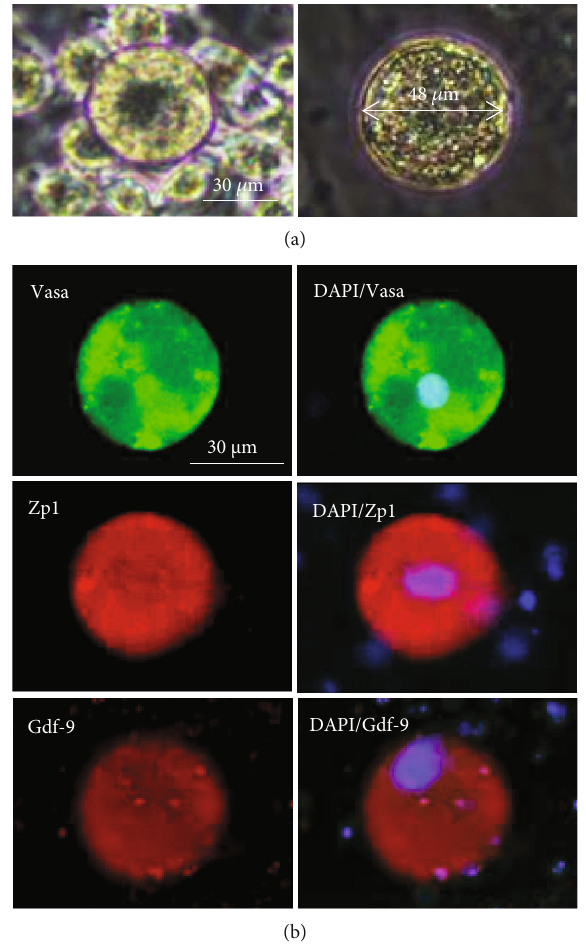
Figure 3: Characteristics of oocyte-like cells generated from female germline stem cells (fGSCs). (a) Phase contrast images of OLCs. Spontaneous generation of large spherical cells that morphologically resembled oocytes. (b) Immuno fl uorescence detection of germ cell and oocyte-speci fi c markers in